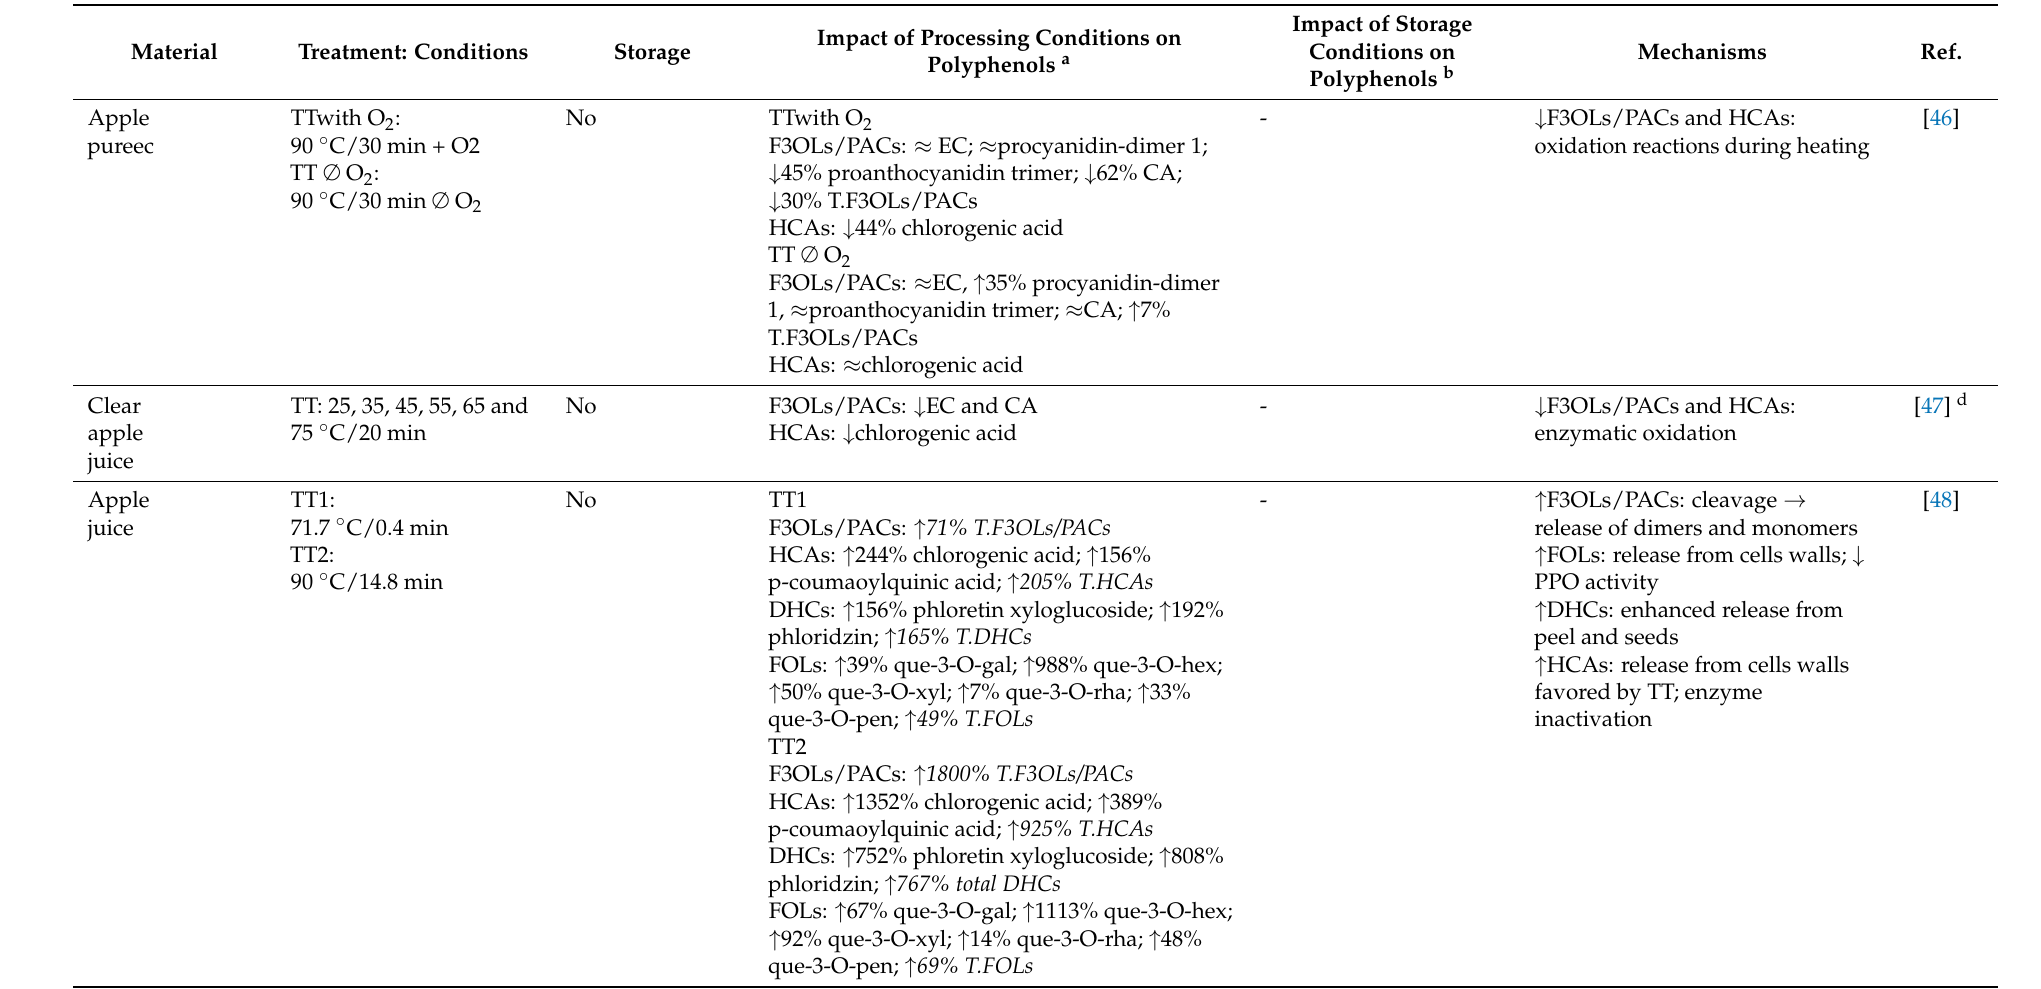
Table 2. Effects of different TT and HPP treatments and storage on the main phenolic compounds in apple